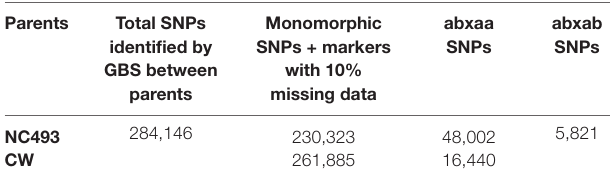
TABLE 1 | Summary of single-nucleotide polymorphism (SNP) markers obtained by genotyping by sequencing of a mapping population derived from NC493 x ‘Chilliwack’